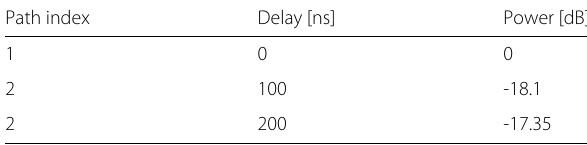
Table 3 Power delay profile of scenario